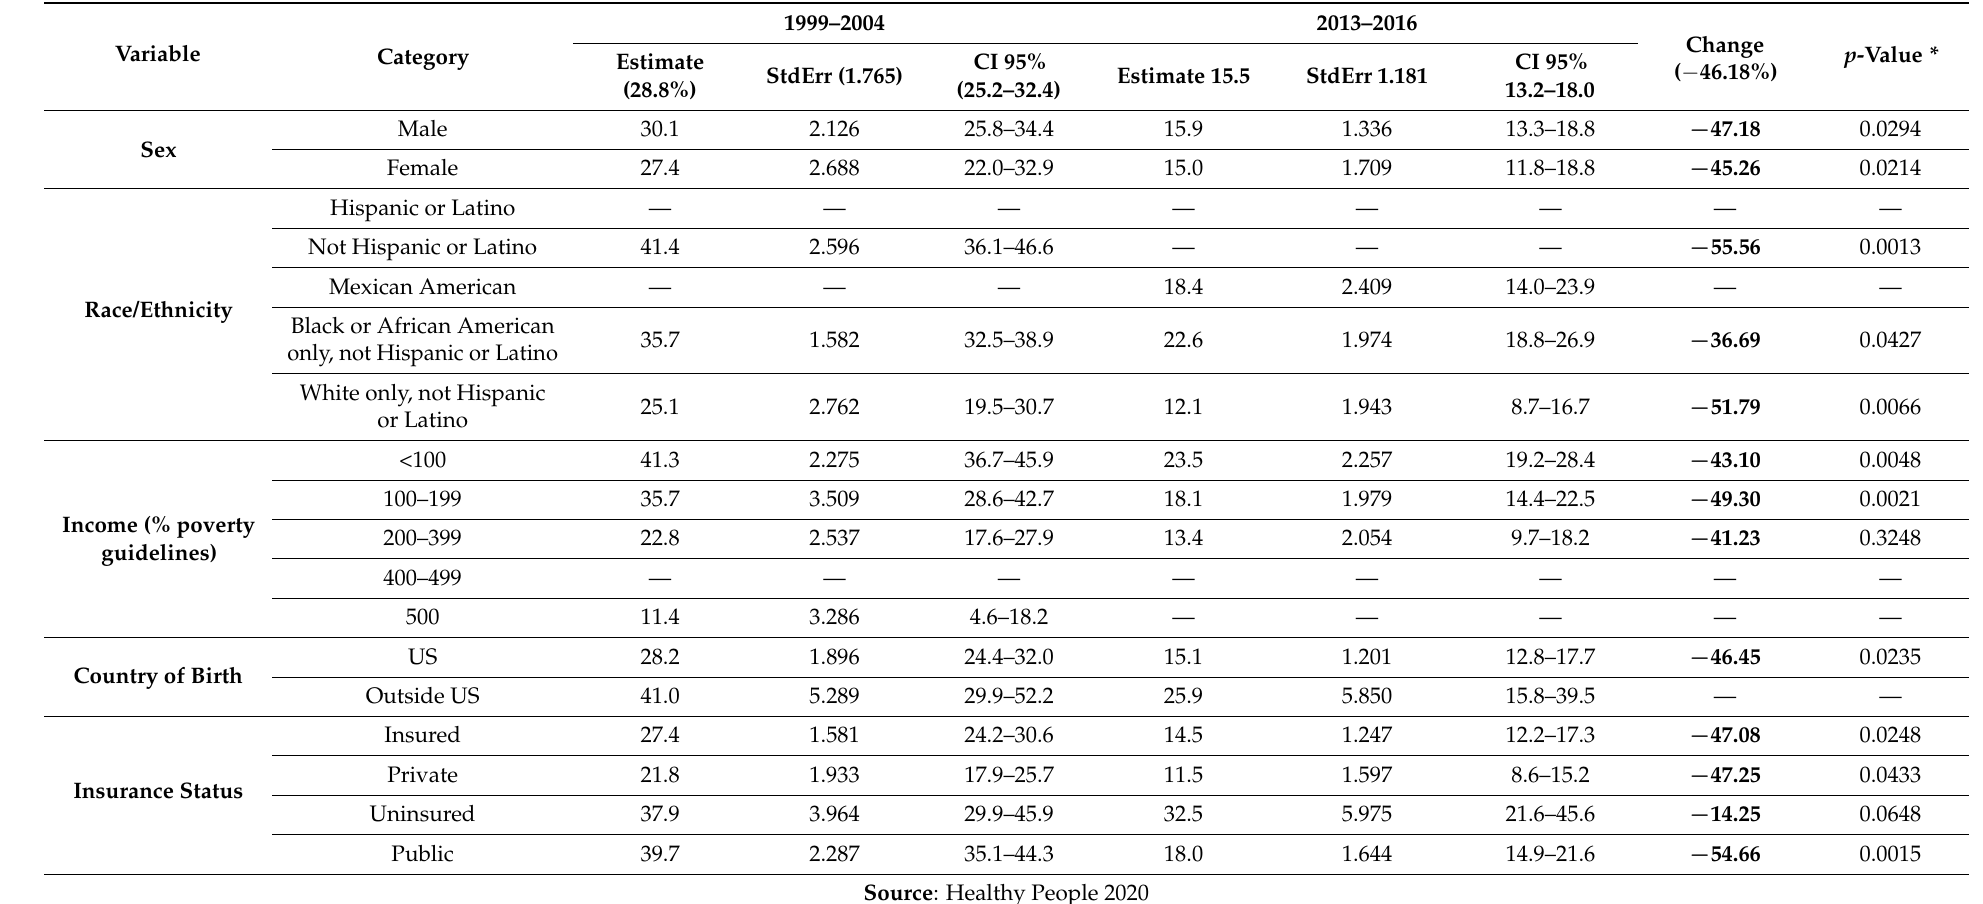
Table 2. Distribution of OH 2.2: decay 6–9 years, according to sociodemographic characteristics. Healthy People 2020. USA,